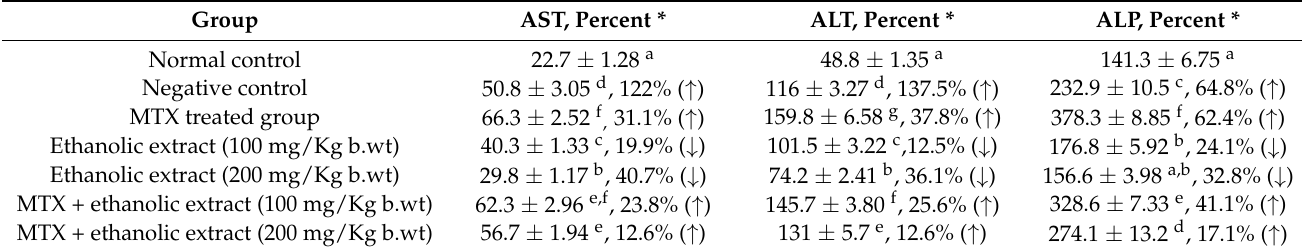
Table 4. Effect of different treatments on the markers of liver function (AST, ALT and ALP).